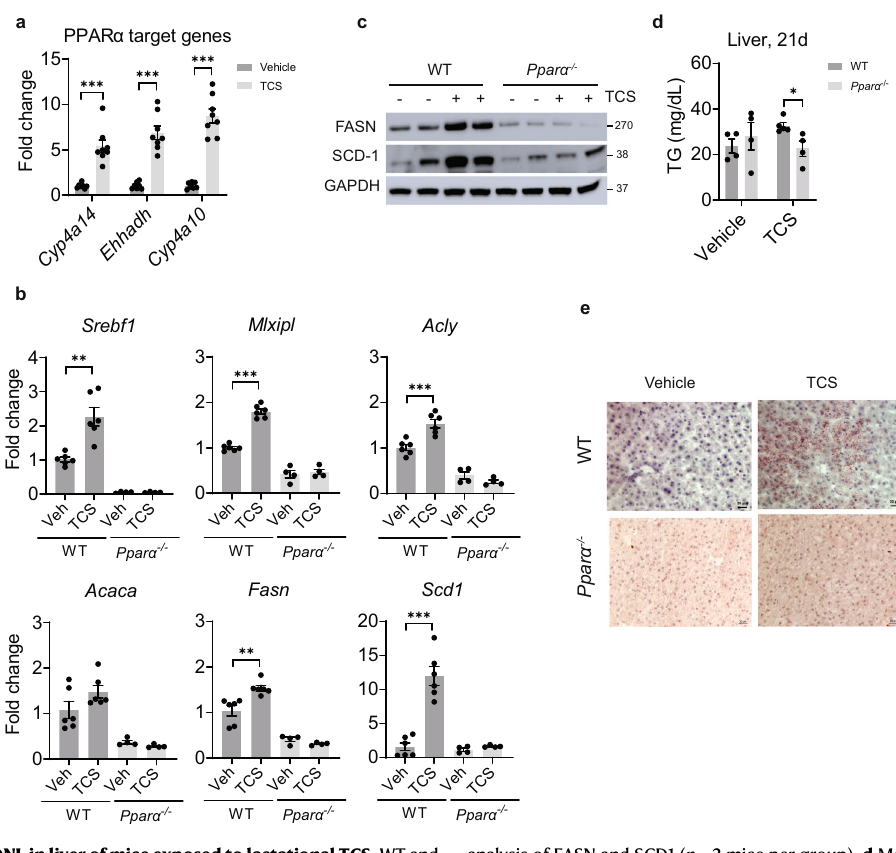
analysis of FASN and SCD1 ( n =2 mice per group). d Measurement of liver trigly- cerides (TG) at 21 days, n =4 mice per group. e Frozen liver sections were stained with ORO ( n =3 per group). Scale bar, 20 μ m. ( a , b and d ) show mean ± S.E., determined by two-tailed Student ’ s test; * P <0.05, ** P <0.01, *** P